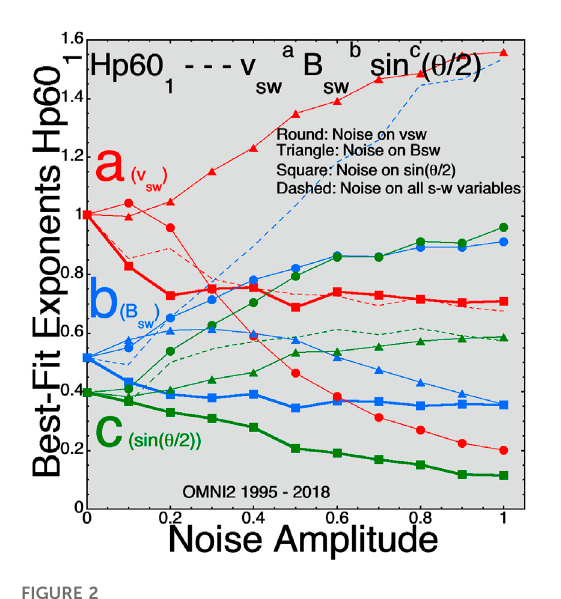
FIGURE 2 For best fi ts to the 1-hr-lagged Hp60 1 index the three exponents (A) (red), (B) (blue), and (C) (green) are plotted as functions of the amplitude of the Gaussian noise added to the three solar-wind